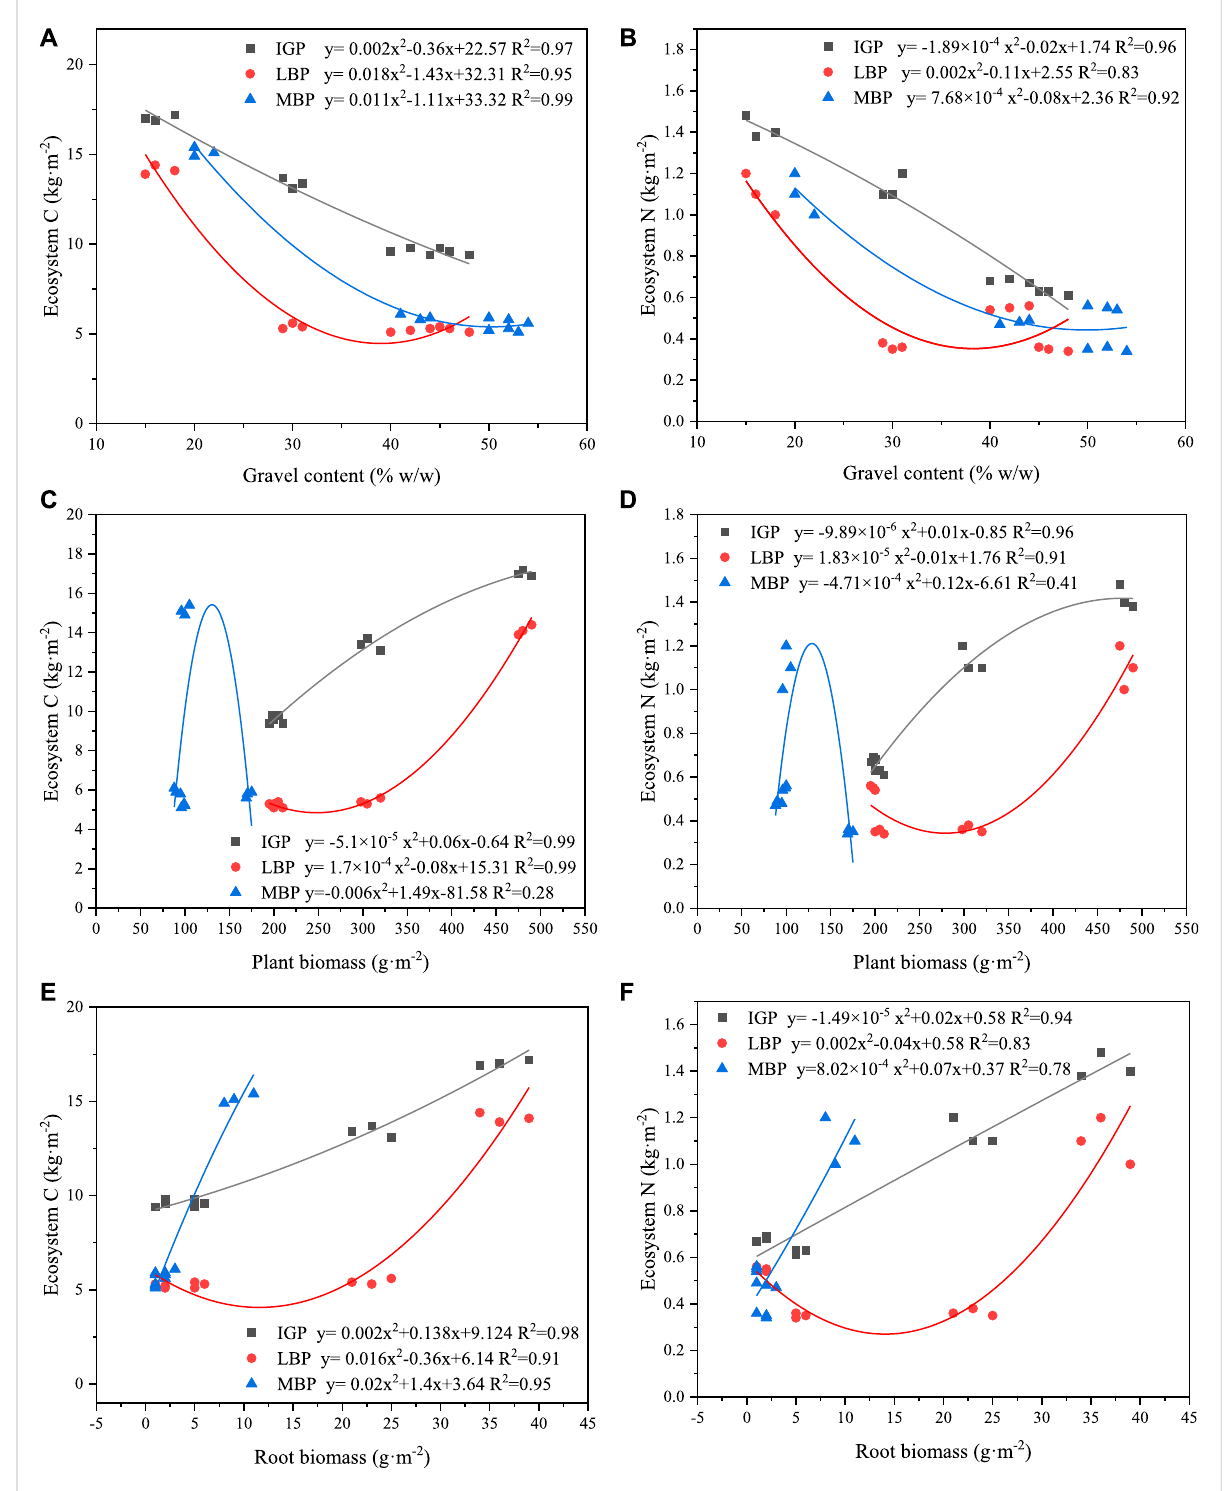
FIGURE 7 Relationship between ecosystem carbon (A) and nitrogen storage (B) with gravel, ecosystem carbon (C) and nitrogen storage (D) with plant biomassandecosystemcarbon (E) andnitrogenstorage (F) withrootbiomass. p < 0.001.IGP;intactvegetationpatch,LBP;largestrippedvegetation patch, MBP; medium stripped vegetation